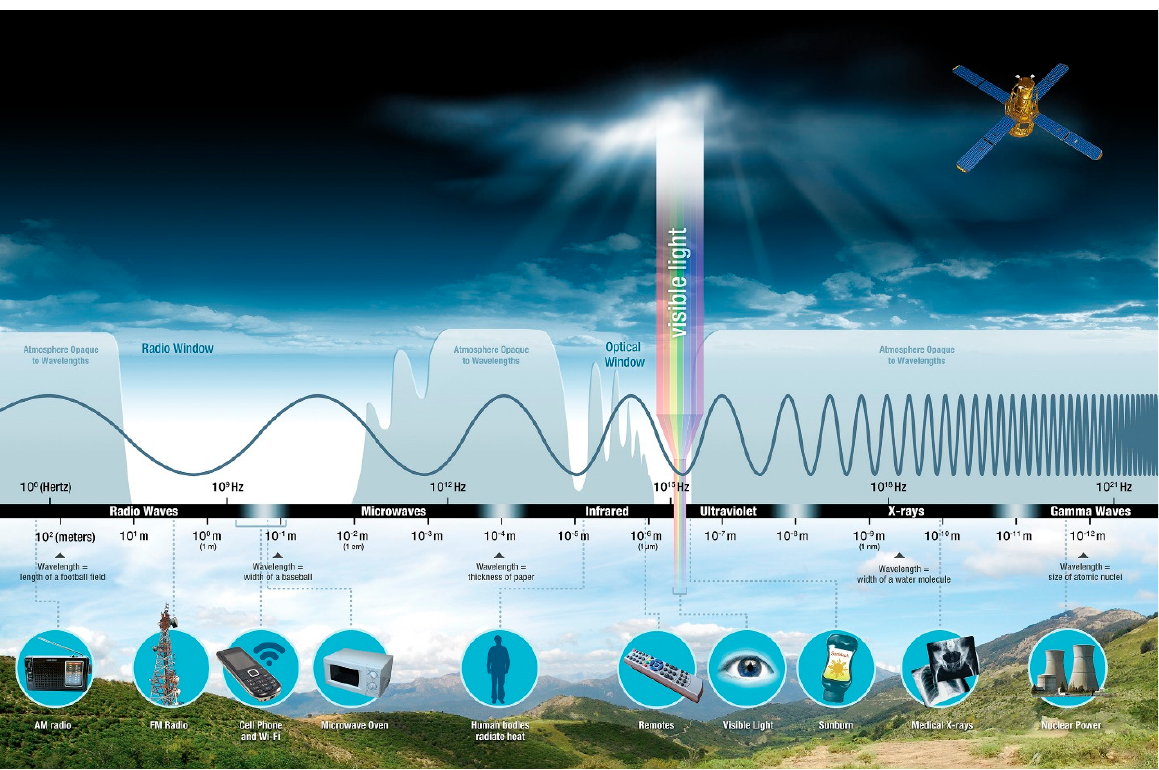
Figure 1. Diagram of the electromagnetic spectrum. Source: NASA Science [2].